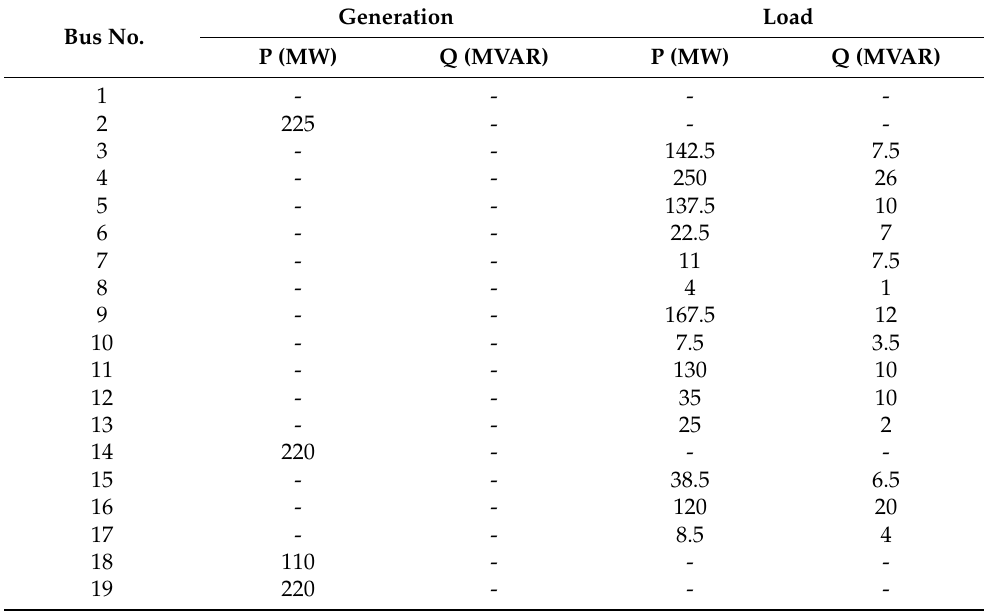
Table A1. Generator and load bus data of the